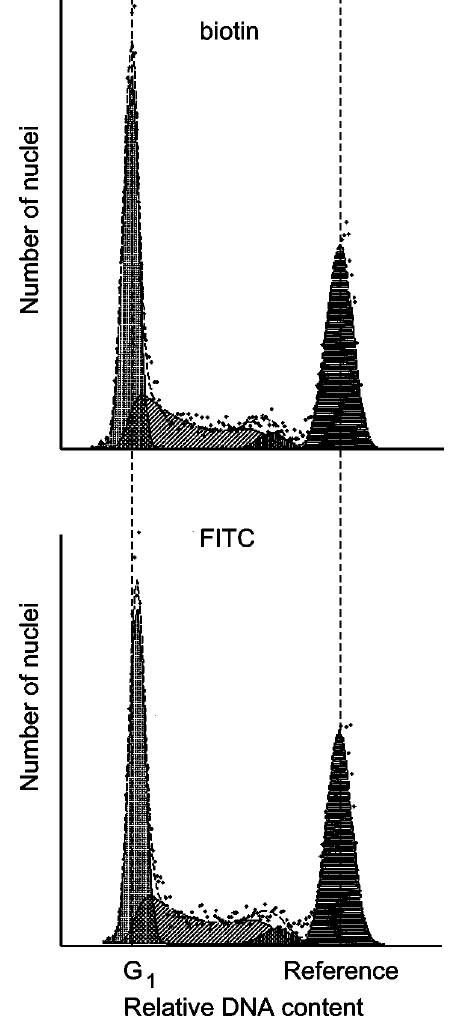
Fig. 3. Comparison of using a secondary biotin-conjugated antibody and a secondary FITC-conjugated antibody for the detection of in- corporated BrdUrd in CHO cells where all cells were labelled with BrdUrd. The peaks to the right are G 1 peaks of human diploid cells added as an internal DNA reference. The left line is drawn through the mean DNA content of biotin-labelled G 1 phase cells. The ratio between the mean DNA contents of the G 1 peak of the human cells, and that of the G 1 peak of the CHO cells was 2.405 and 2.379 with biotin- and FITC-conjugated antibodies, respectively. The ratio be- tween the mean DNA content of FITC-labelled and biotin-labelled G 1 phase cells was 1.03 ( n =